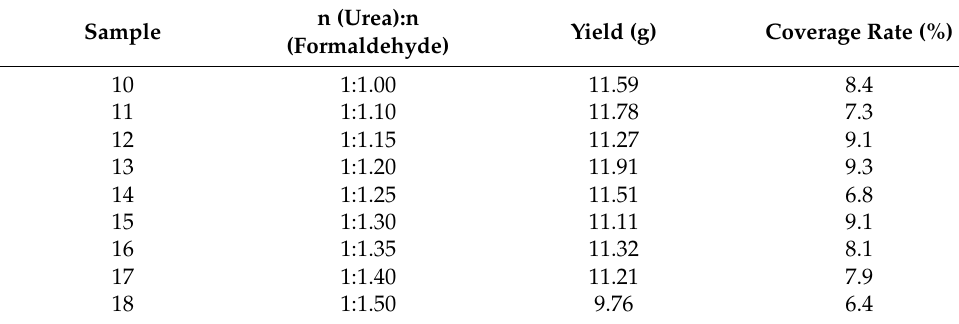
Table 11. Microcapsule yields and coverage rates in the single factor experiment.